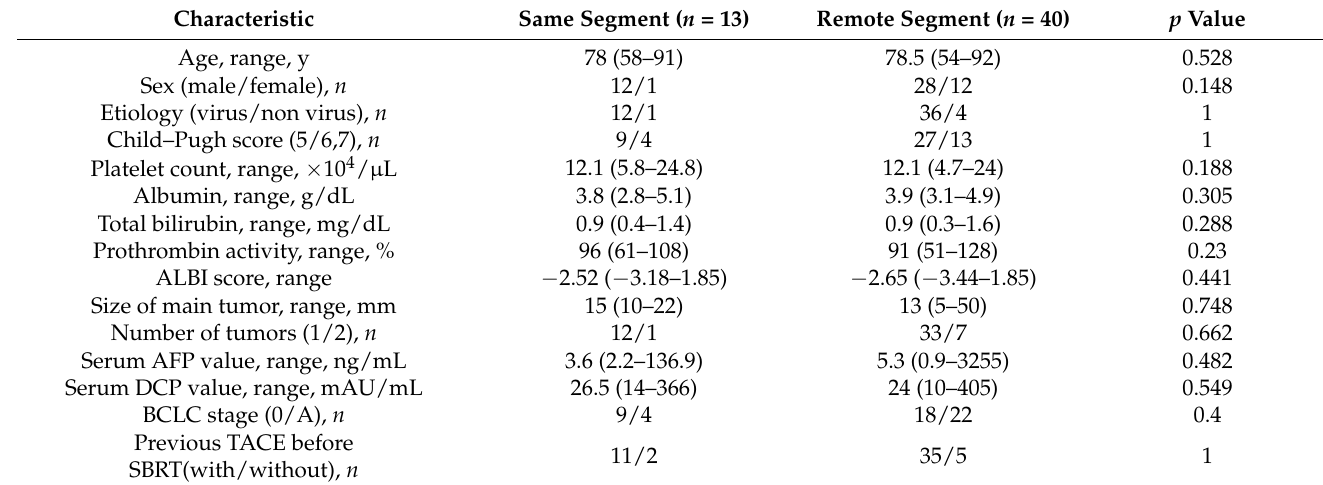
Table 2. Patient background for same-segment ( n = 13) and remote-segment ( n = 40) groups.